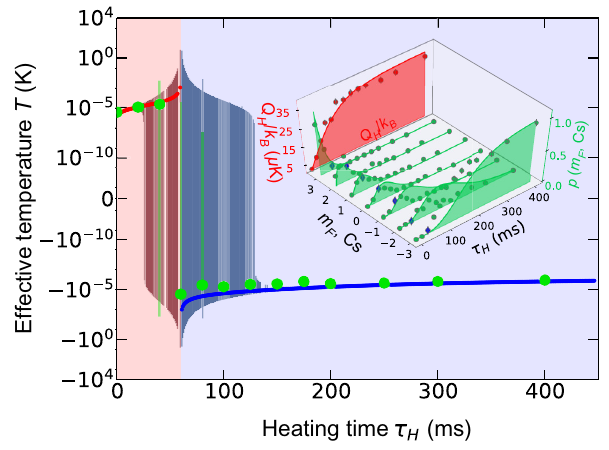
FIG. 2. The evolution of the effective spin temperature. By fitting the Cs population with P n = aP + + ( 1 − a ) P − and Boltz- / k )/ Z , a positive (red) mann distributions P ± = exp ( − E Cs B T ± n and negative (blue) temperature is extracted. The presented pos- itive or negative temperature has a fit contribution of 98%. The large error bars indicate the transition area from positive to effective negative temperature. The green dots represent the extracted effective temperatures from measurements. The back- ground colors indicate the positive (red) and negative (blue) effective temperature regimes. The inset shows the time evolu- tion of the spin population p n and of the exchanged heat Q H of the heat engine reported in Ref.